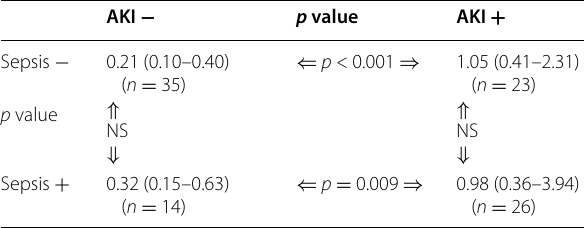
and without AKI (no statistical differences were found between septic and non-septic status). (Table 1). These differences were unrelated to the pres- The index values were significantly related to AKI pres- ence of sepsis (Table 2). Patients who developed AKI pre- sented higher median index values (1.05, IQR 0.41–2.31 ence and severity according to AKIN criteria (Fig. 2). In for patients without sepsis; 0.98, IQR 0.36–3.94 for sep- contrast, index values did not appear to be influenced by sepsis, either in AKI or non-AKI patients (Table 2). tic patients) than those without AKI (0.21 IQR 0.10–0.40 [TIMP-2] [IGFBP7] values increased in 44% of patients in non-septic patients and 0.32 IQR 0.15–0.63 for those · within 12 h of ICU admission; index values decreased with sepsis) with p < 0.001 between subgroups with in all other patients. Overall, a repeated determina- tion of [TIMP-2] [IGFBP7] did not show any differences · between non-AKI/AKI and non-septic/septic subgroups Table 2 Worst [TIMP-2] [IGFBP7] distribution within 12 h · (Additional file 2: Figure S1). of ICU admission depending on AKI and sepsis We divided the patients into 3 subgroups depending on the cut-offs proposed in previous studies [15] (Table 3). Although baseline sCr showed no statistically signifi- cant difference between subgroups, baseline eGFR sig- nificantly declined at index values >2.0. AKI occurrence and AKIN 2 during ICU stay were significantly more ≥ frequent in the groups with index >0.31. However, the need for RRT did not differ according to the index val- ues. There were also differences between subgroups in (AKI vs. AKI ) and (Sepsis vs. Sepsis ) represent the presence or absence + − + − of either AKI during hospital stay or sepsis upon admission, respectively. Values the incidence of shock, SAPS II score and ICU length of show median and percentiles 25–75. p represents the statistical intra-group stay. Patients with high-risk values also had longer ICU differences. [TIMP-2] [IGFBP7] values given in ((ng/mL) 2 /1000) · length of stay but not hospital length of stay, both with AKI acute kidney injury, NS no statistical